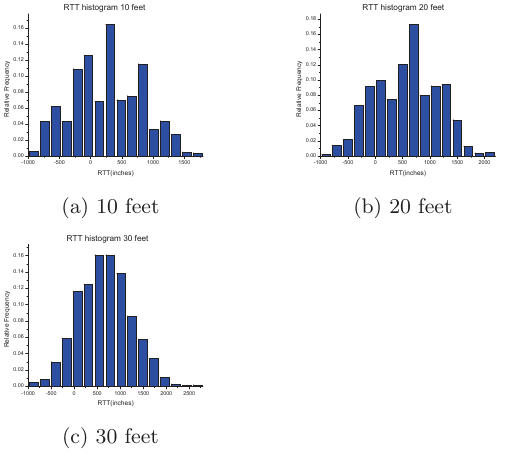
Figure 4: Round Trip Time (RTT) Histograms (inches)